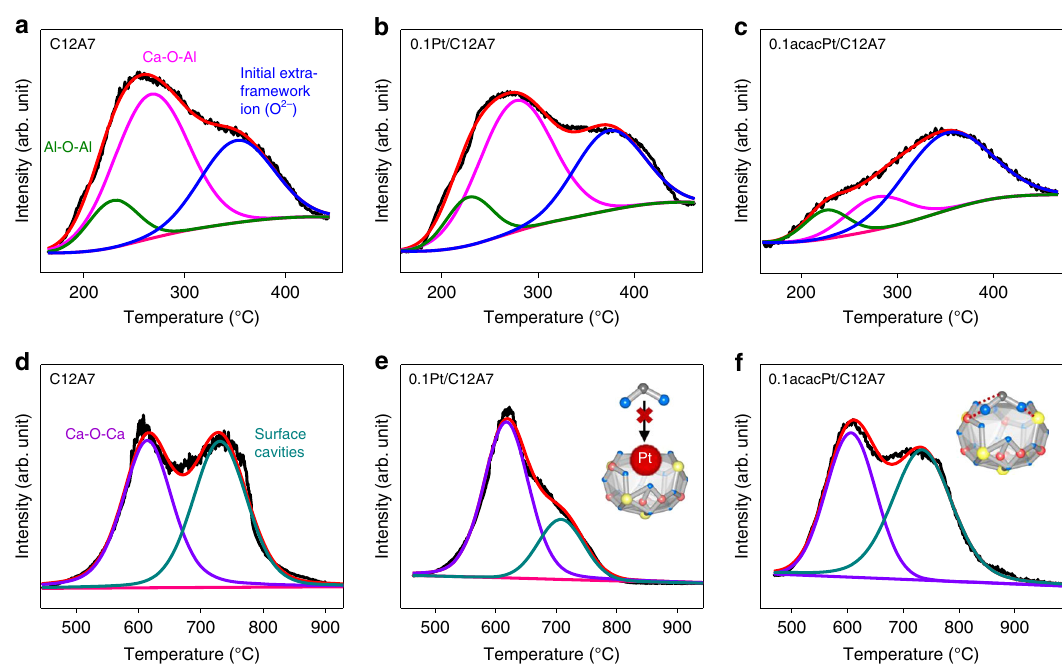
Fig. 3 CO 2 -TPD studies of Pt/C12A7 with different Pt precursors. CO 2 -TPD pro fi les for pure a , d C12A7, b , e 0.1Pt/C12A7, and c , f 0.1acacPt/C12A7 in the low and high-temperature regions, respectively. The fi tted data for the different temperature regions represent adsorbed CO 2 desorption from various kinds of basic sites on the sample surfaces, such as Al-O-Al, Ca-O-Al, initial extra-framework ions (O 2 − ), Ca-O-Ca and surface cavities. The difference between the inset of e , f indicate the suppressed CO 2 adsorption in 0.1Pt/C12A7 due to the occupied surface cavities by Pt single C12A7 and 0.1Pt/C12A7 in the low temperature region (150 – 450 °C). However, tridentate adsorption of CO 2 on the surface cavities (725 °C) is suppressed in 0.1Pt/C12A7 (Fig. 3e), which should be ascribed to the domination of Pt single atom (Fig. 3e inset). In contrast, different CO 2 adsorption behavior of 0.1acacPt/C12A7 appear in the low temperature region with almost no change in the high-temperature region compared to pure C12A7 (Fig. 3c, f), indicating the accumulation of Pt clusters or NPs on surface Al-O-Al and Ca-O-Al sites of C12A7 instead of the surface cavities. Therefore, single Pt atoms should be con fi ned in the unique surface cavities of C12A7. Here, the amount of adsorbed CO 2 molecules can be estimated through the calibration of CO 2 standard gas by mass spectrometry. According to our previous work of CO 2 adsorption on C12A7:e − , each surface truncated cage only corresponds to one CO 2 molecule (Fig. 3f inset), which can be used to determine the concentration Table 2, the amount of surface truncated cage is ca. 9.1 µmol g − 1 ,